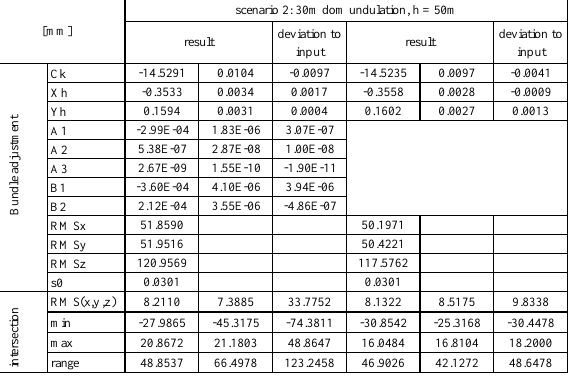
Table 6. Results of flight simulation for scenario 2 Table 5 and Table 6 summarize the results of the described